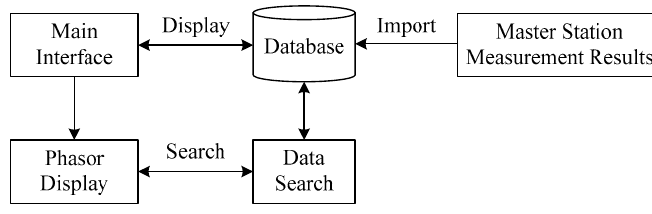
Figure 10. The framework of the phasor comparison.